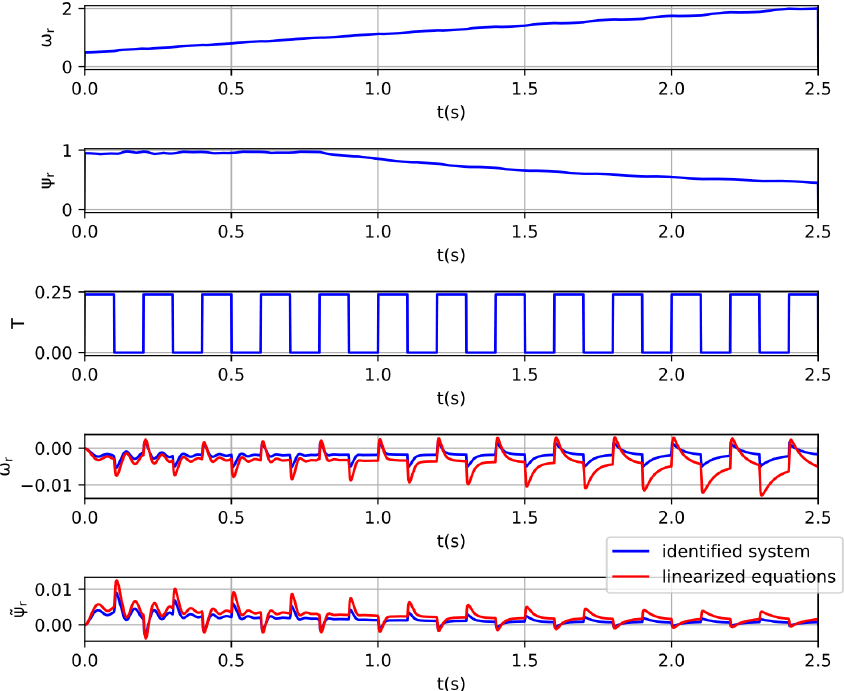
Figure 11. Performance of the observer in a wide range of the rotor speed for observer gains acquired: using fitness func- tion based on linearized equations (red error signals) and using fitness function based on identified system (blue error signals).